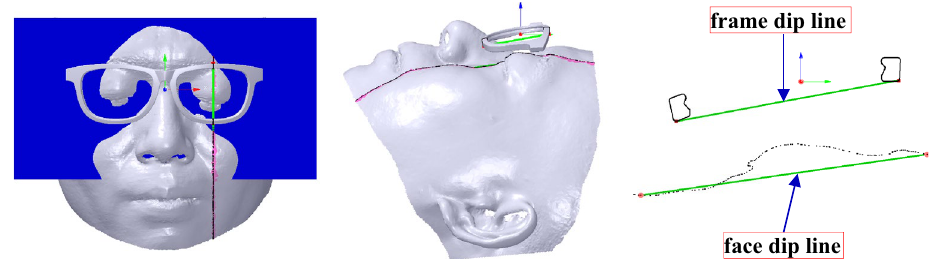
Figure 14. The dip line of the glasses and the face are marked with green lines. From left to right: the front view, the side view, the side view without the fame and